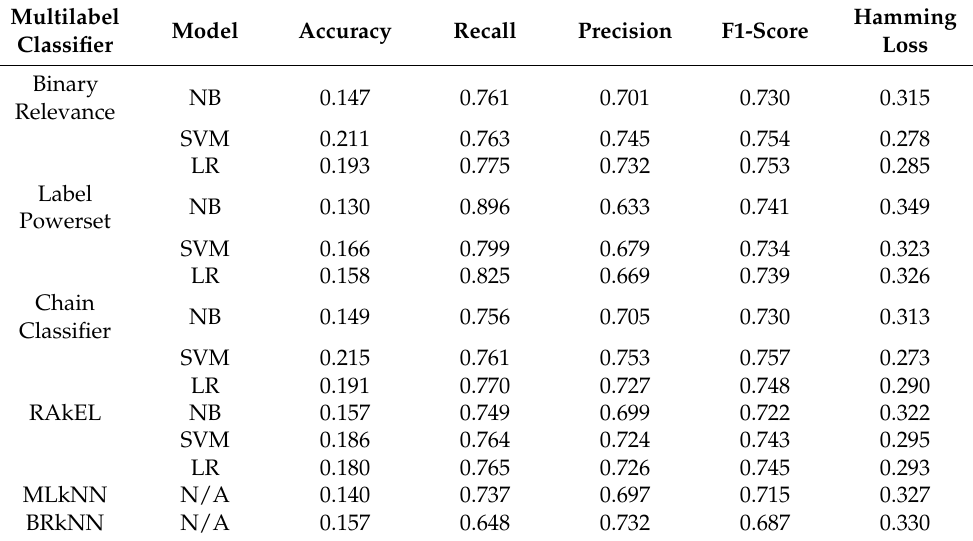
Figure 2. Machine learning development process. Table 3. Overall ML models performance.